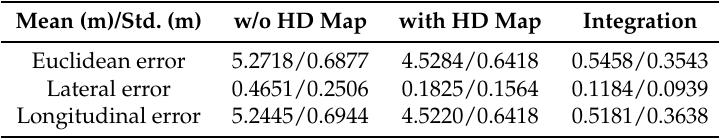
Table 2. Means and standard deviations of streetlight